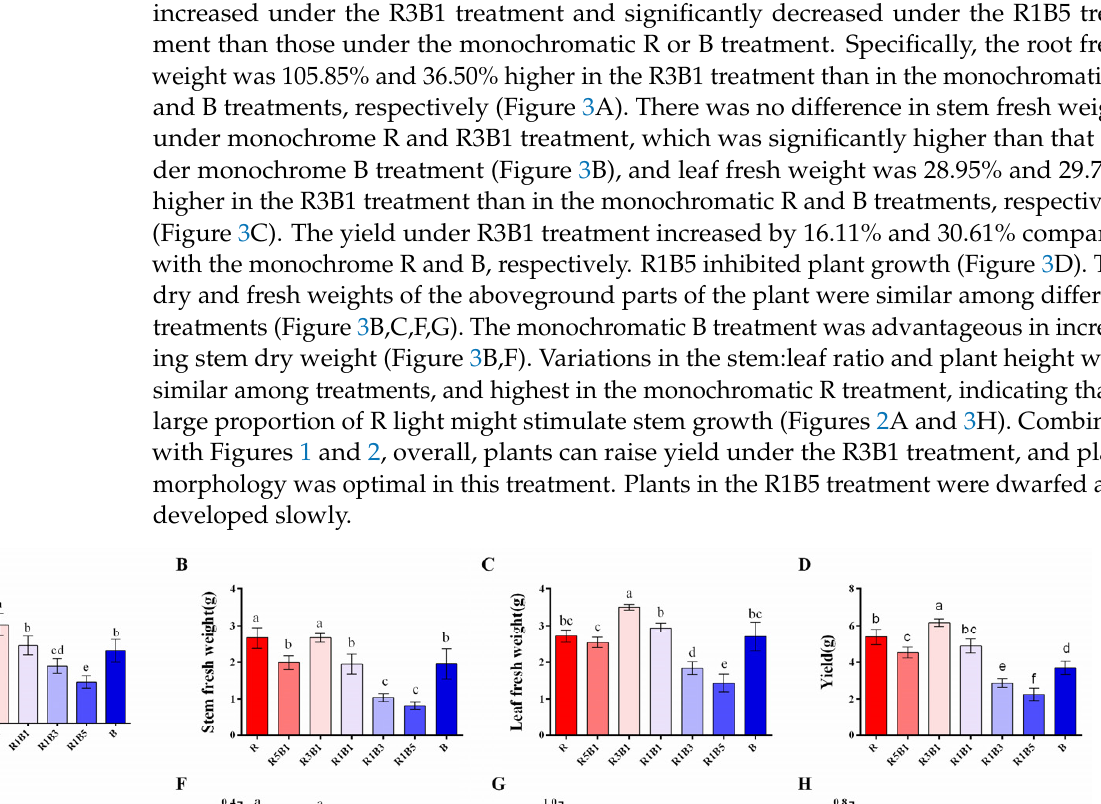
Figure 3. Fresh weight of each part of the plant ( A – C ), Yield: sum of shoot fresh weight ( D ), dry each part of the plant ( E – G ), and stem:leaf ratio ( H ) of coriander plants as affected by the different spectra.